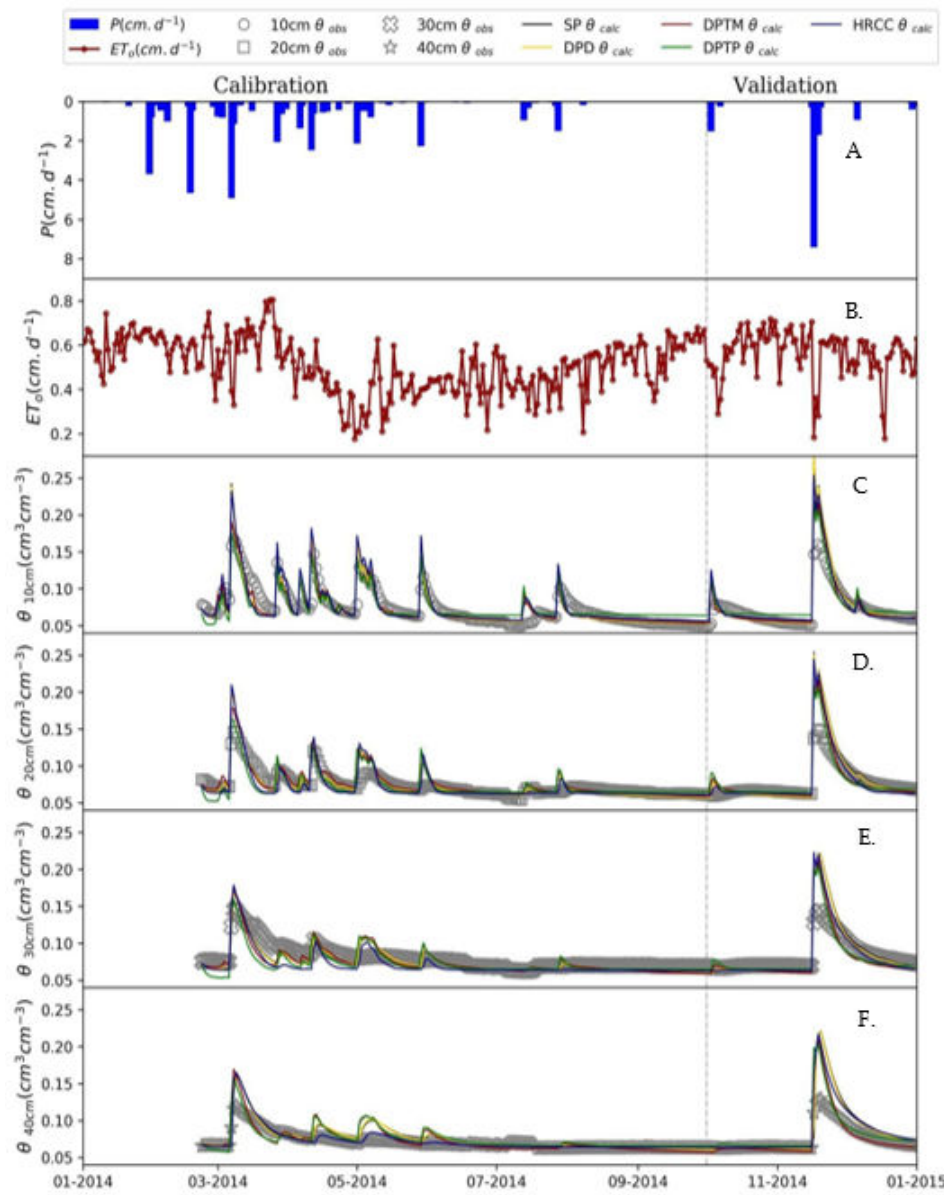
Figure 6. Soil water content observed and simulated by the models in the BR-CST tower. ( A ). Pre- cipitation; ( B ). Potential Evapotranspiration; ( C ). Soil moisture at 10 cm depth; ( D ). Soil moisture at 20 cm depth; ( E ). soil moisture at 30 cm depth; and ( F ). soil moisture at 40 cm